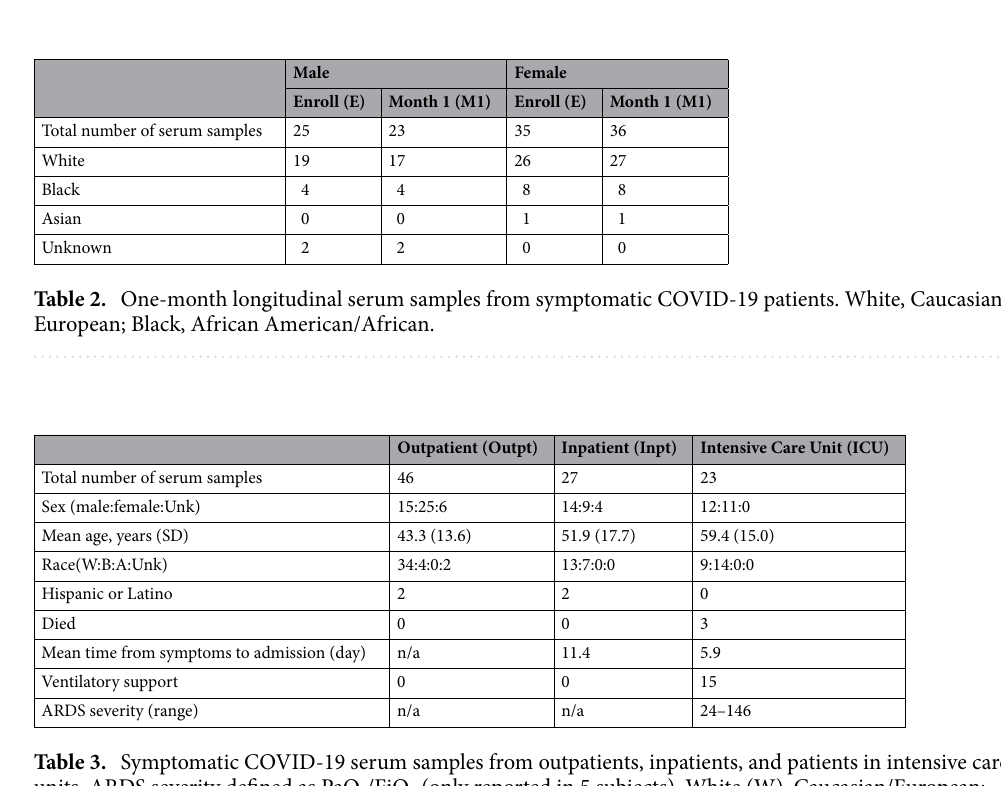
Table 1. Serum samples from healthy negative individuals, asymptomatic positives, and symptomatic COVID-19 patients. White (W), Caucasian/European; Black (B), African American/African; Asian (A); Unk (unknown); SD standard deviation.